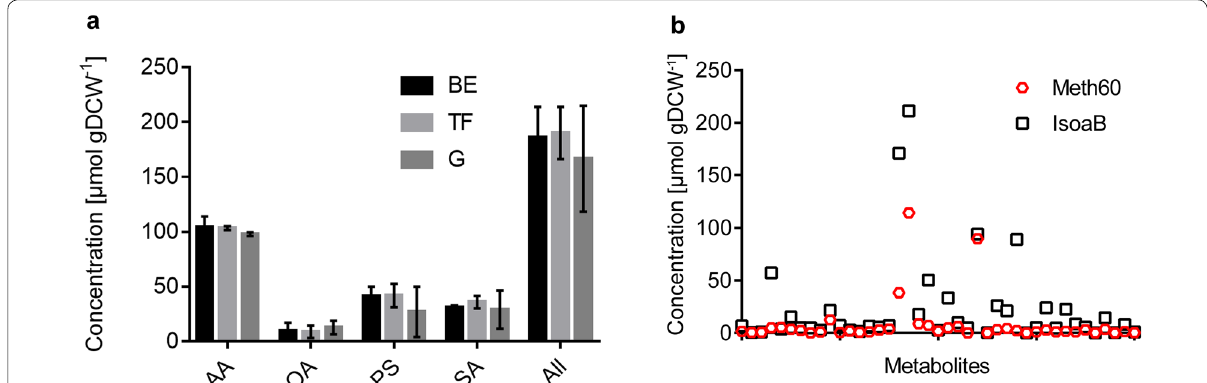
Fig. 6 a Extraction performance of the three extraction procedures. BE: boiling ethanol, 75% (v/v) ethanol boiling in 95 °C for 4 min; TF: thawing– freezing in liquid nitrogen and cryostat at 30 °C in 50% (v/v) methanol for three cycles; G: grinding in liquid nitrogen in 50% (v/v) methanol. − Metabolites were divided in four parts, which were: AA amino acids, OA organic acids, PS phosphate sugars, SA sugar alcohols. All means the summation of these four parts. b Intracellular metabolites in Streptomyces ZYJ-6. Based on IsoaB and Meth60 as the quenching solution, and thawing– freezing (TF) in liquid nitrogen and cryostat at 30 °C within 50% (v/v) methanol for three cycles as the extraction procedure. IsoaB: isoamylol with − base solution 5:1 (v/v) at 30 °C; and Meth60: 60% methanol at 30 °C, respectively. Base solution consisted of acetone:ethanol − − red polygon represents intracellular metabolites from Meth60 quenching and the black square represents intracellular metabolites from IsoaB. Data were averages standard deviation of the three replicate samples, each of which was analyzed in ±